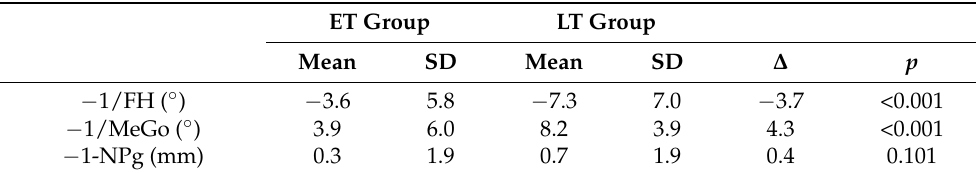
Table 5. Lower incisors changes in NonEx Patients with FFA need (intentional proclination for space regain excluded).